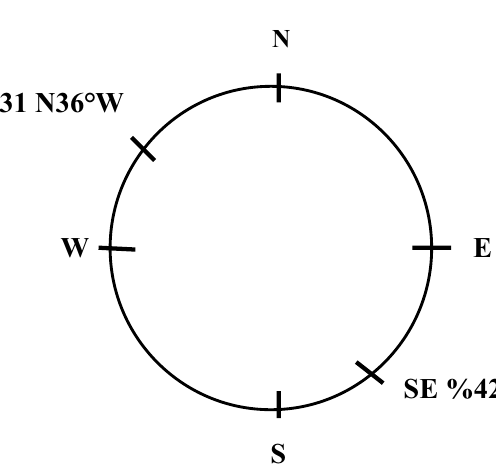
Fig. 19 The prevailing wind direction and frequency of Dagdibi (Pozantı) station according to the Rubinstein formula